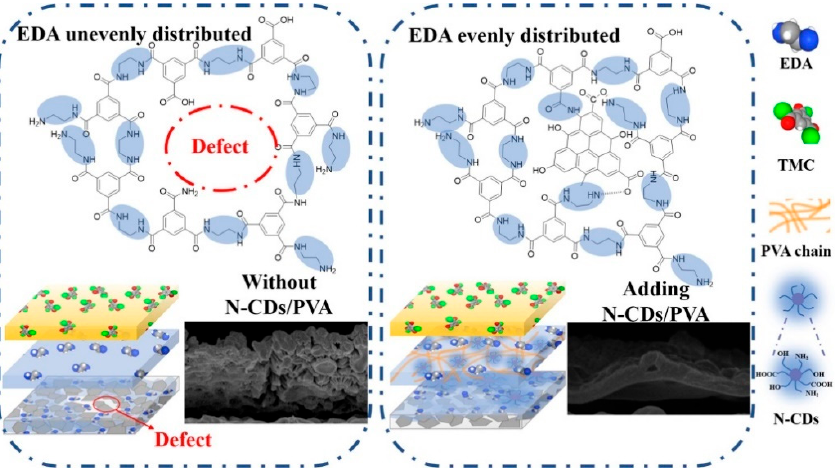
Figure 5. Schematic representation of the IP reaction mechanism: with no N-CDs and PVA ( Left ); including N-CDs and PVA ( Right ).